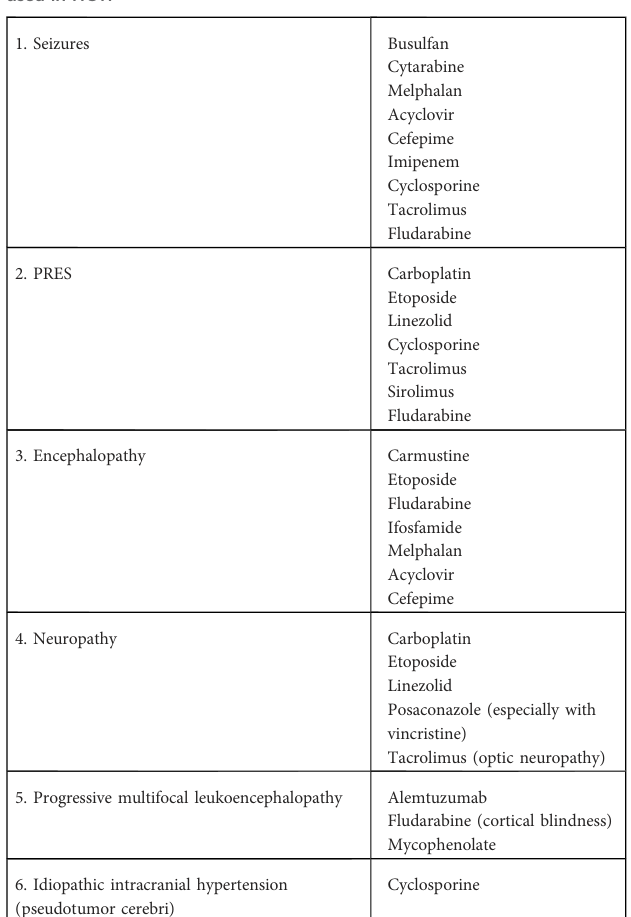
TABLE 3 Potential neurological consequences with medications commonly used in